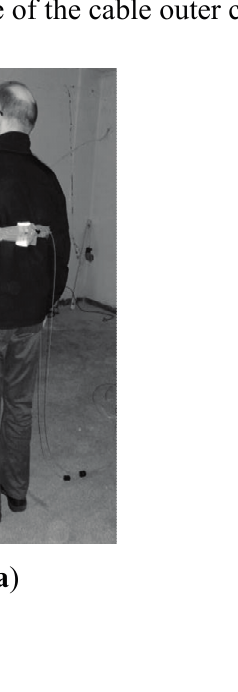
Figure 5. Path loss experimental setup in an empty office room with a human subject: ( a ) human subject with antennas; ( b ) setup including ferrite beads on coaxial cables to reduce the influence of the cable outer conductor